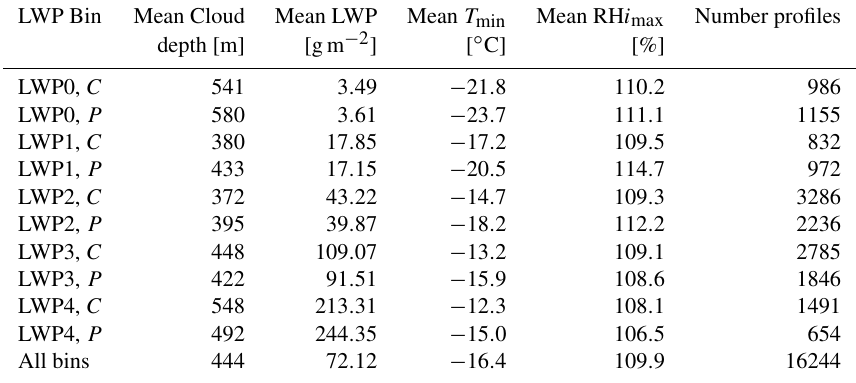
Table 1. Summary statistics for the sampled clouds in each LWP bin. The last row is the aggregate sample from all LWP bins. LWP